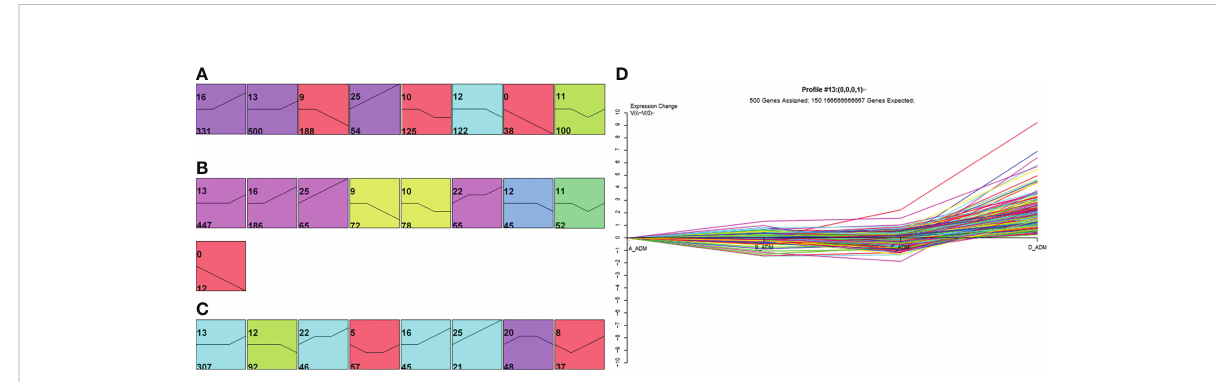
FIGURE 1 Expression patterns of differentially expressed proteins (DEPs) in the three groups. Expression patterns of DEPs in the adalimumab group (A) , secukinumab group (B) , and control group (C) . Coloured models enriched a statistically signi fi cant number of proteins. The number on the top left corner indicates the serial number of models, and the bottom left corner reveals the number of proteins enriched. (D) Representative protein expression pattern of Model 13 ( A – D represent baseline, week 1, week 4, and week 12, respectively) in the adalimumab